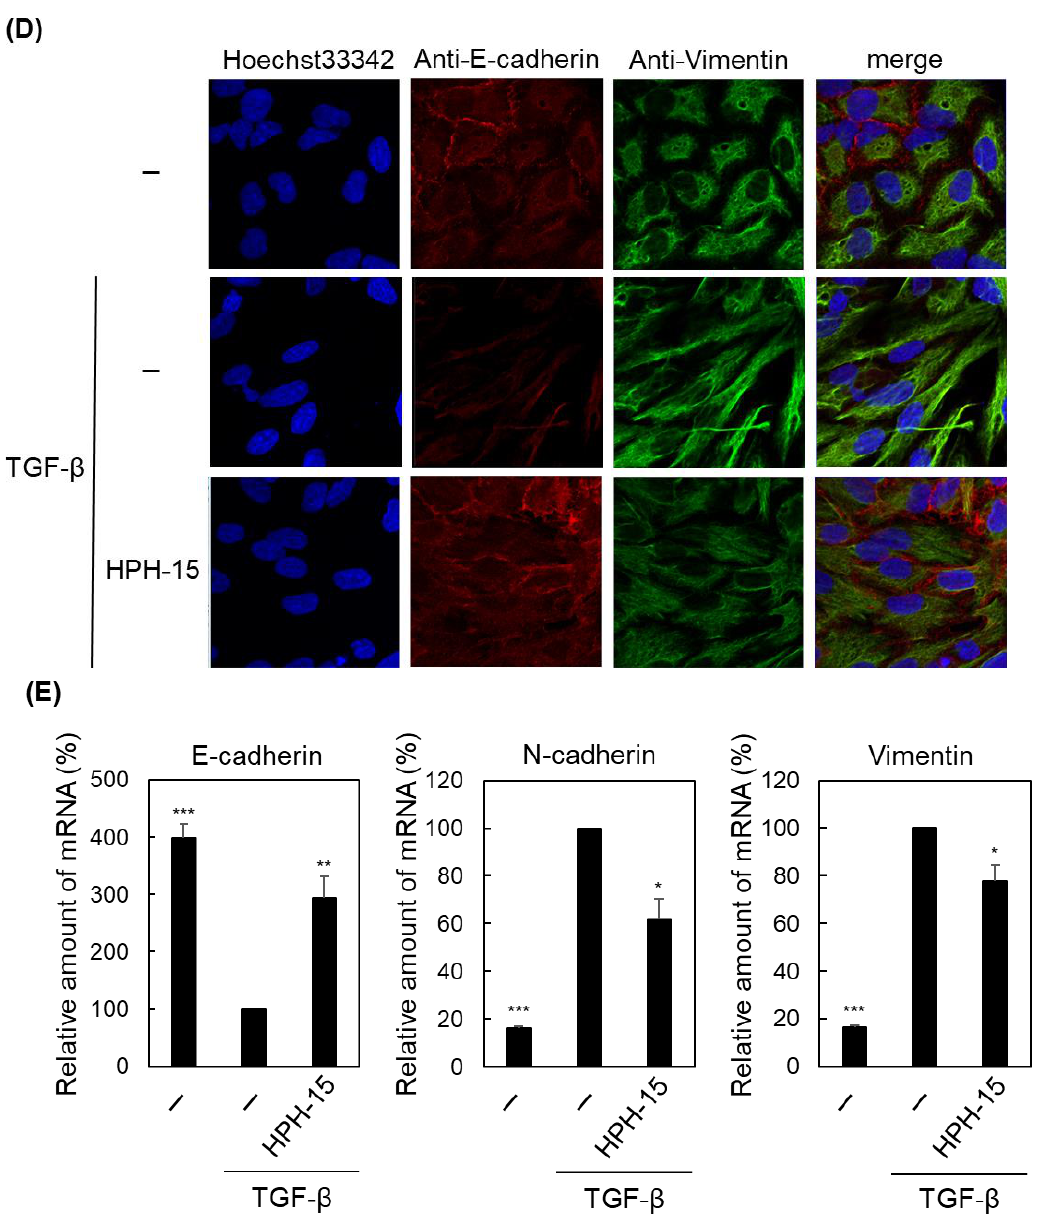
Figure 2. Anti-EMT activity of HPH-15. ( A ) Morphology of TGF- β -stimulated A549 cells with HPH-15. After incubating the cells for 3 d in the presence of HPH-15 (10 µ M) and TGF- β (10 ng/mL), cell morphology was observed using a microscope. ( B ) Protein levels of E-cadherin, N-cadherin, and Vimentin in TGF- β -stimulated A549 cells with HPH-15. After incubating the cells for 3 d in the presence of HPH-15 (10 µ M) and TGF- β (10 ng/mL), the cells were lysed. The lysate was analyzed by immunoblotting. ( C ) Quantification of the amount of E-cadherin, N-cadherin, and Vimentin. The intensity of the bands in ( B ) was quantified using ImageJ. Each value was normalized by that of GAPDH, and relative values are shown. ( D ) Protein localization of E-cadherin and Vimentin in a TGF- β -stimulated A549 cell treated with HPH-15. After incubating the cells for 3 d in the presence of HPH-15 (10 µ M) and TGF- β (10 ng/mL), cellular immunostaining was performed for microscopy. Hoechst33342 was used for nuclear staining. ( E ) mRNA levels of E-cadherin, N-cadherin, and Vimentin in TGF- β -stimulated A549 cells treated with HPH-15. After incubating the cells for 1 d in the presence of HPH-15 (10 µ M) and TGF- β (10 ng/mL), RNA was extracted from the cells, and RT-PCR was performed. Relative values are shown. * p < 0.05, ** p < 0.01, *** p < 0.001 compared with samples treated with TGF- β and without